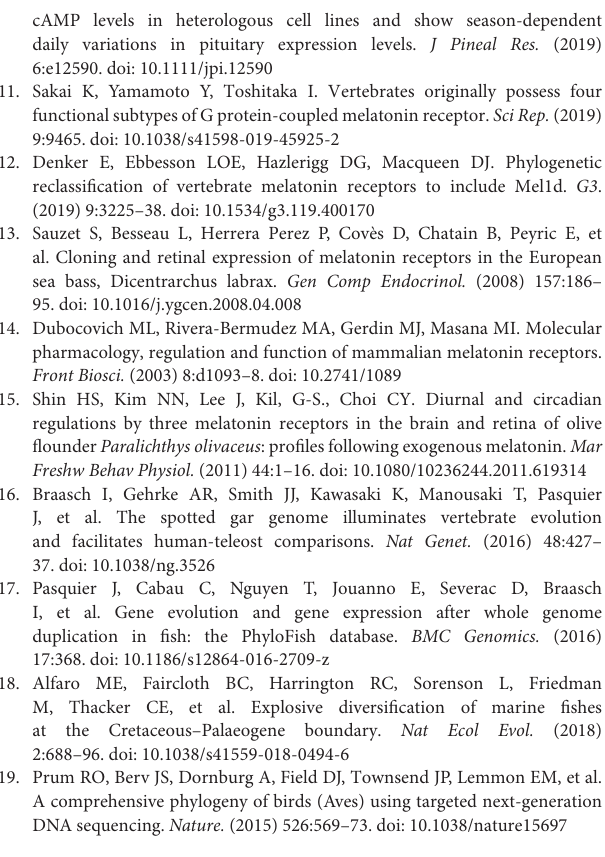
Supplementary Figure 9 | Evolution of the chromosomes carrying the mtnr genes in Clupeocephala. A. Comparison of the chromosomal distribution of mtnr in three clupeocephalan species including the denticle herring, the Northern pike and the Japanese medaka (HdrR). The color in the chromosomes indicates region homologous with chromosomes carrying the mtnr in the spotted gar (used as reference genome for the pre-3R). The figure was adapted from the multi-genome comparison between the spotted gar and three clupeocephalan species performed on the Genomicus browser. B. Evolutionary scenario of